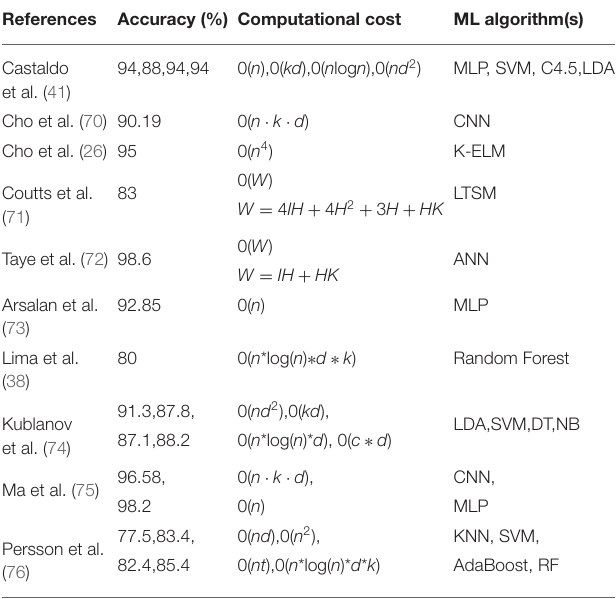
TABLE 4 | Recent publications based on HRV + Machine Learning. The accuracy produced and the theoretical computational cost required by the algorithm. References Accuracy (%) Computational cost ML